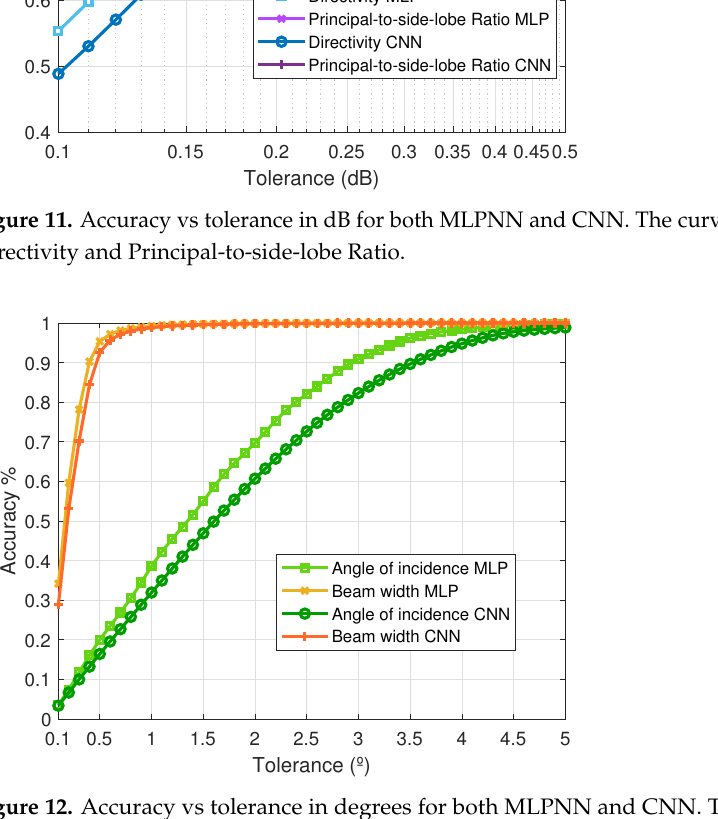
Figure 12. Accuracy vs tolerance in degrees for both MLPNN and CNN. The curves shown corre- spond to the Angle of maximum radiation and Beam